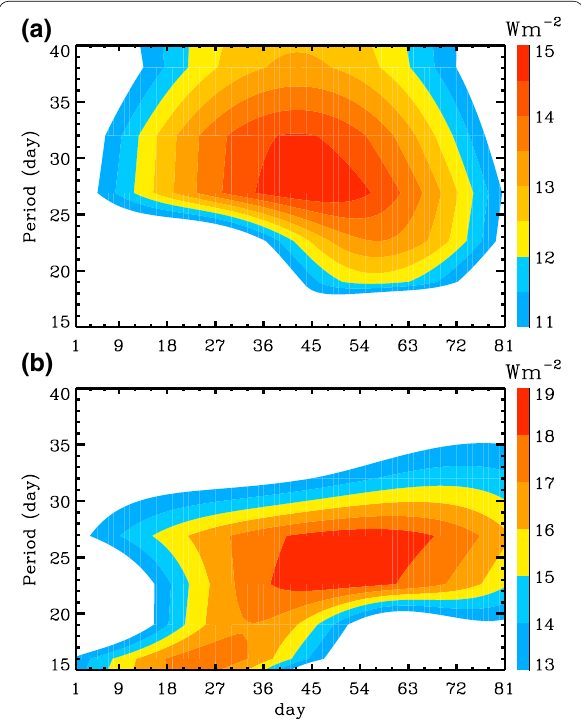
Fig. 9 Fitted 27-day oscillation from a Maui meteor radar and c Hilo radiosonde observations and b reanalysis data over Maui